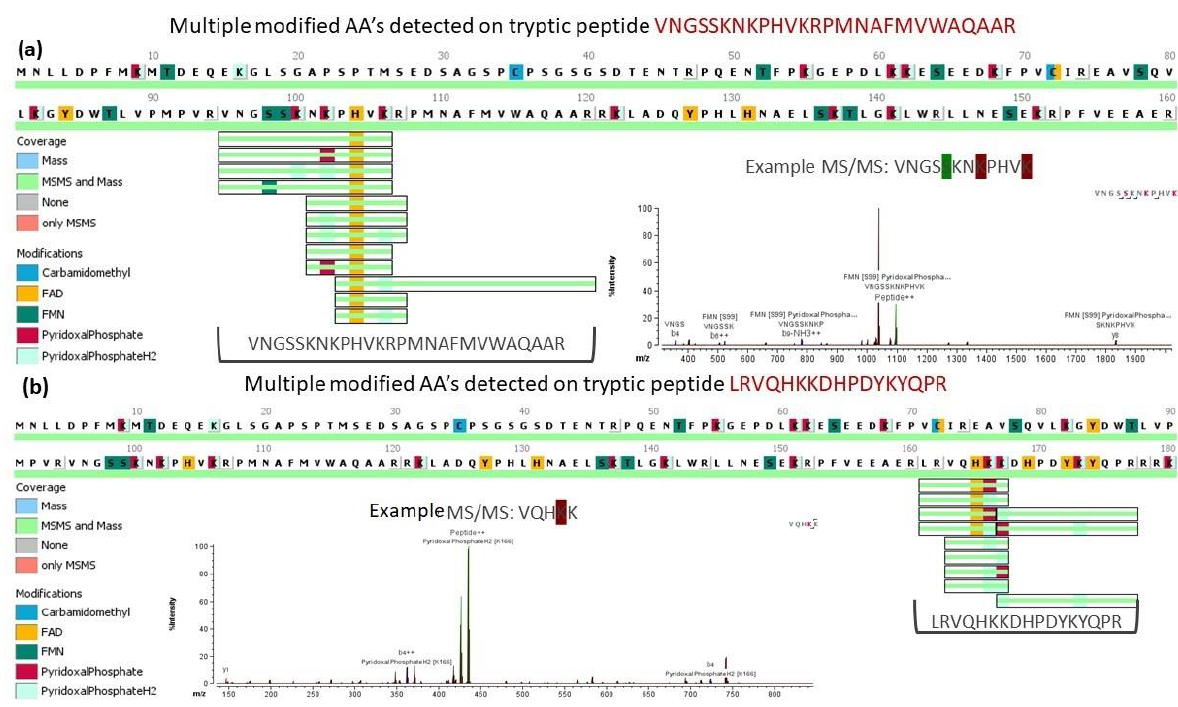
Figure 3. MS/MS spectra showing modifications: MS spectra shown for representative peptide showing the highlighted residues where both mass and MS/MS data were obtained with example for FAD ( a ) and PLP ( b ).